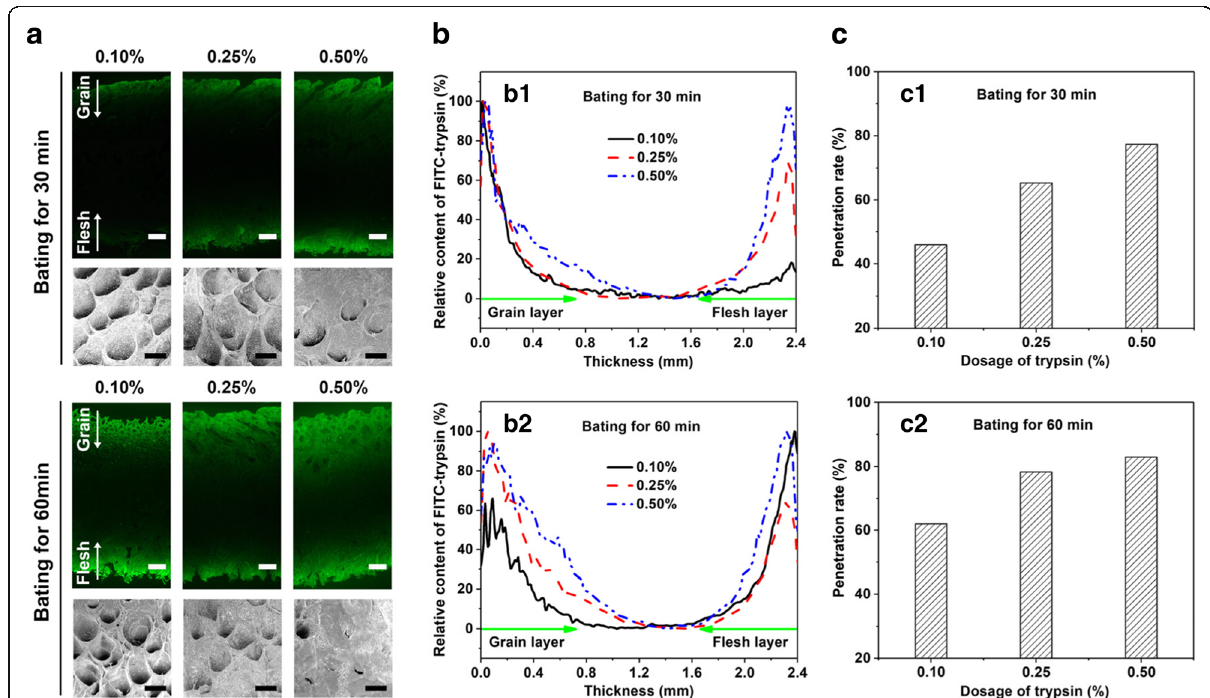
Fig. 2 ( a ) Fluorescence micrographs of vertical sections (bar = 500 μ m) and SEM micrographs of pelt surfaces (bar = 200 μ m) from the pelts bated with different dosages of trypsin and FITC-trypsin mixture for 30 min and 60 min; ( b ) relative contents and ( c ) penetration rates of FITC-trypsin in the pelts bated for 30 min (b1, c1) and 60 min (b2, c2) obtained by analysis of (a) using Image J